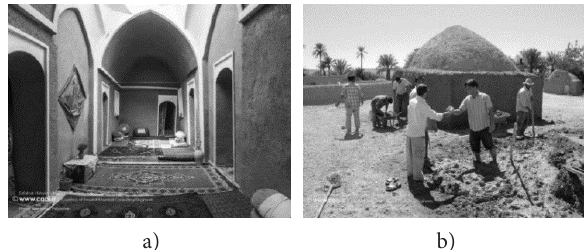
Figure 1. A participatory design process: Village of Esfahak (source: Emaratkhorshid, n.d.)